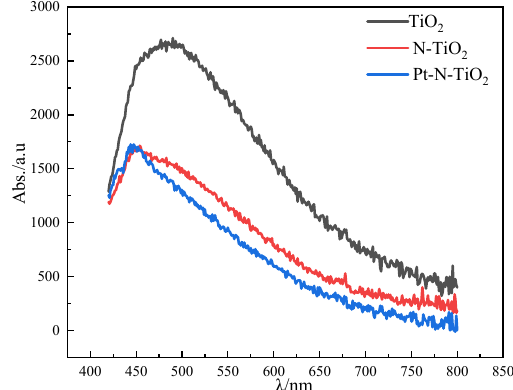
Figure 5. PL pattern of each nanotube.